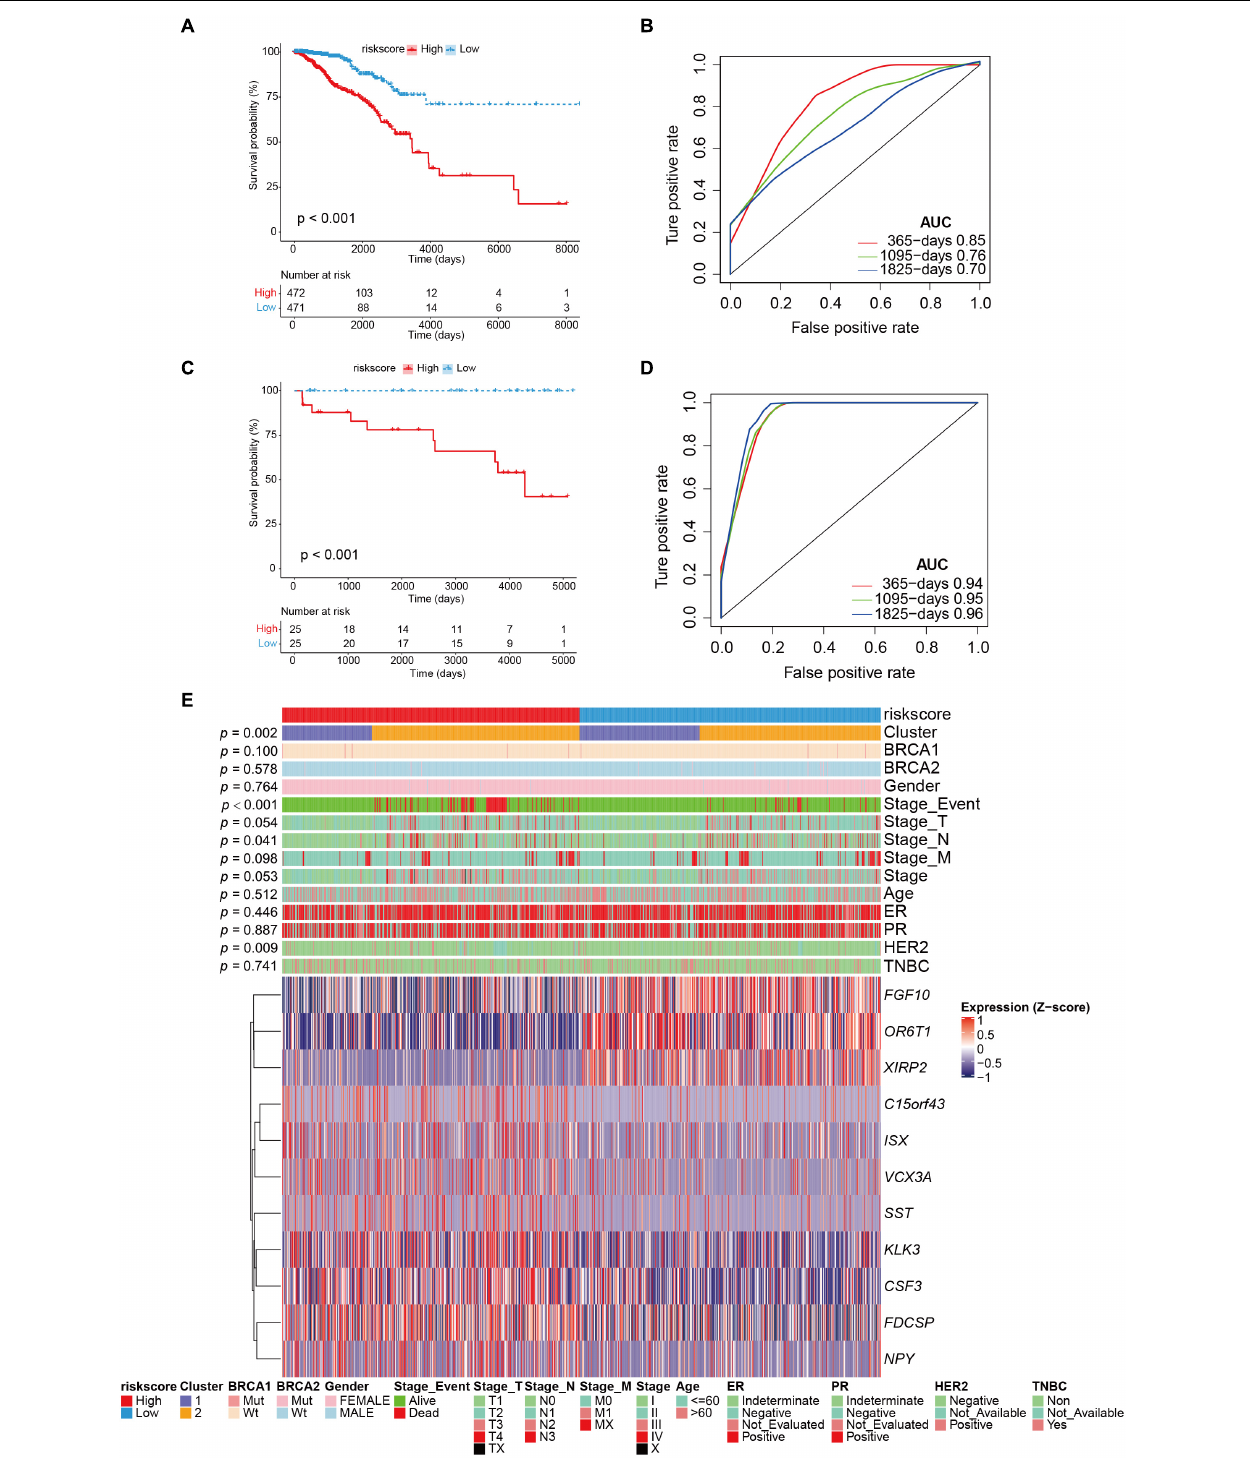
FIGURE 4 | The performance of risk model and external validation. (A) Kaplan–Meier curve showed the overall survival in patients with high risk and low risk ( p < 0.001). (B) The prognostic values of GVRM in 1-, 3-, and 5-year OS with AUC = 0.85, 0.76, and 0.7, respectively. (C) Kaplan–Meier curve showed the overall survival in the validation group (ICGC-BRCA-KR) with high risk and low risk ( p < 0.001). (D) The prognostic values of GVRM in validation group in 1-, 3-, and 5-year OS with AUC = 0.94, 0.95, and 0.96, respectively. (E) The abundance of 11 significant genes (involved in GVRM) with clinical features in the training group